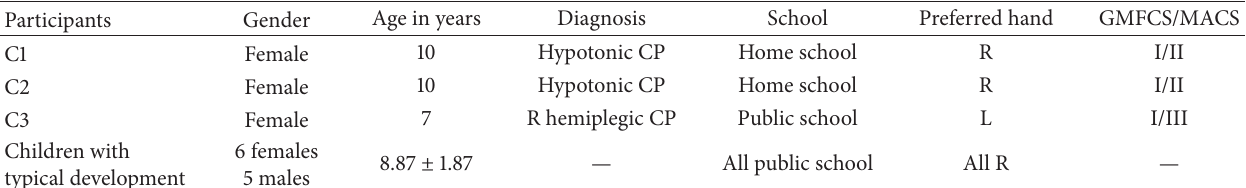
Table 1: Characteristics of participants in the study.